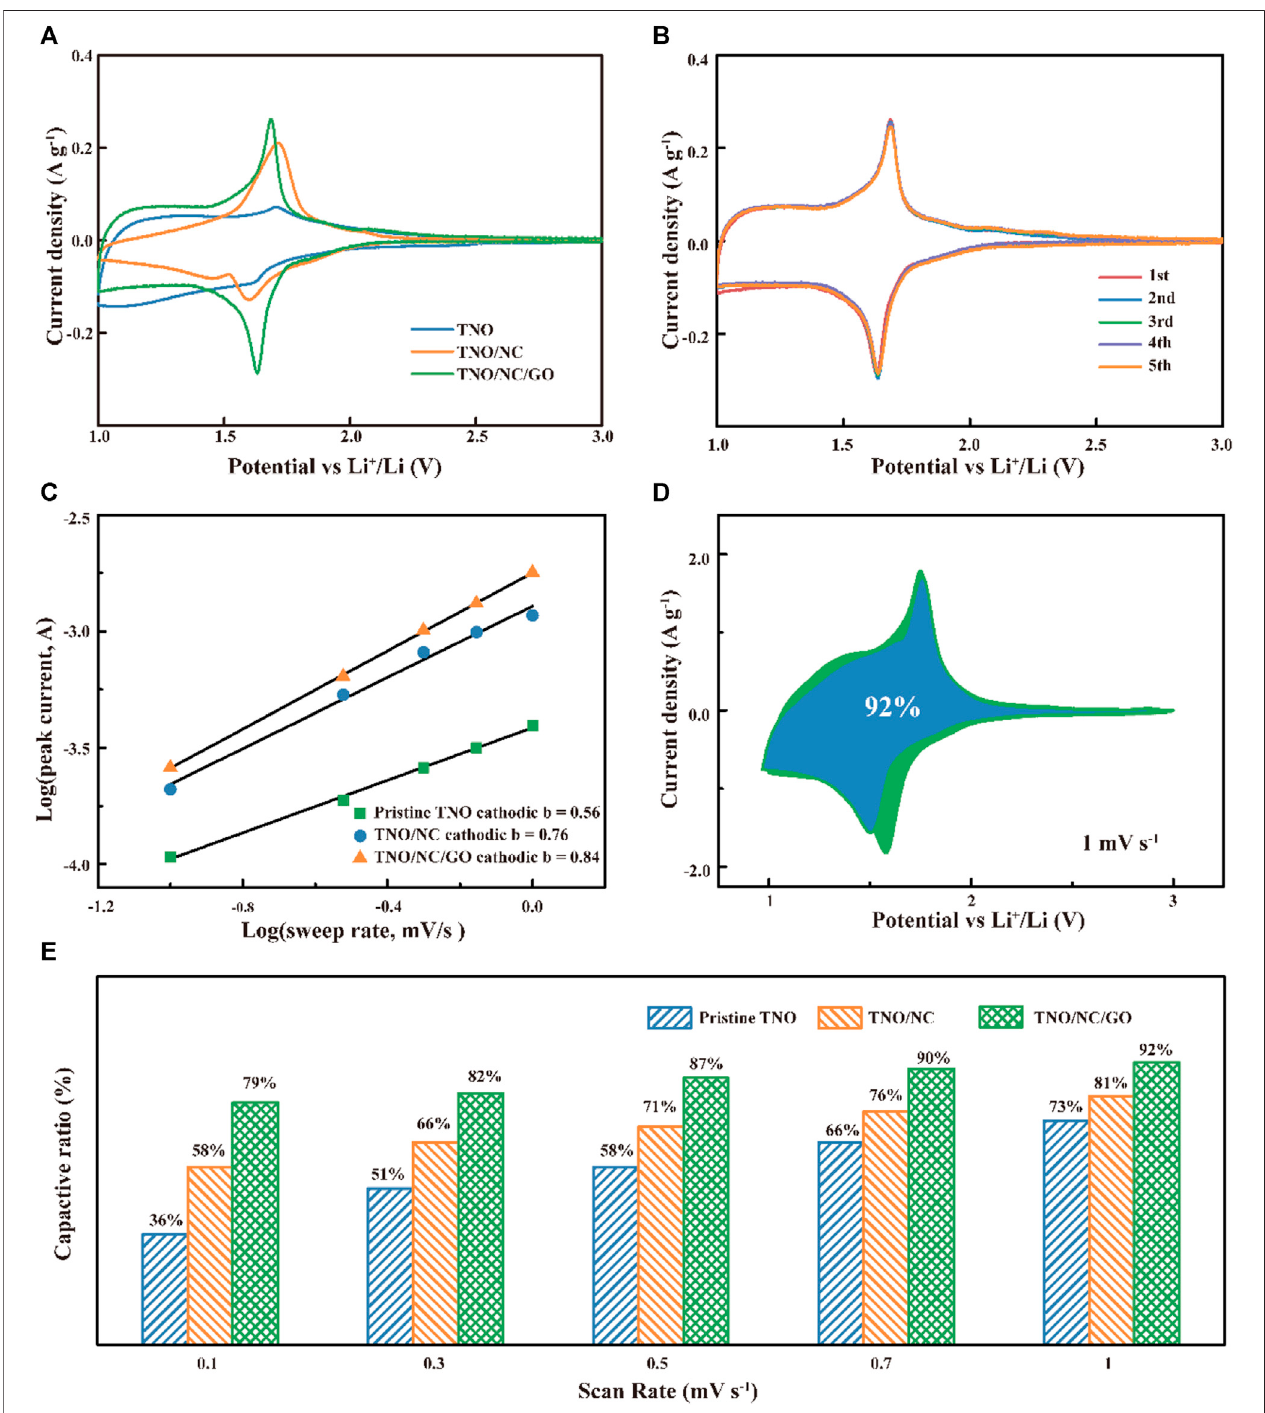
FIGURE5|(A) Comparisonofcyclicvoltammetrycurvesatascanrateof0.1 mV s − 1 ; (B) CVofTNO/NC/GOelectrodesforLIBs. (C) theb-valueobtainedfromthe relationship between the peak current and sweep rate; (D) CV curves of TNO/NC/ GO with separation between total current and capacitive currents at 1 mV s − 1 ; (E) capacitive contributions at different sweep rates for different samples.